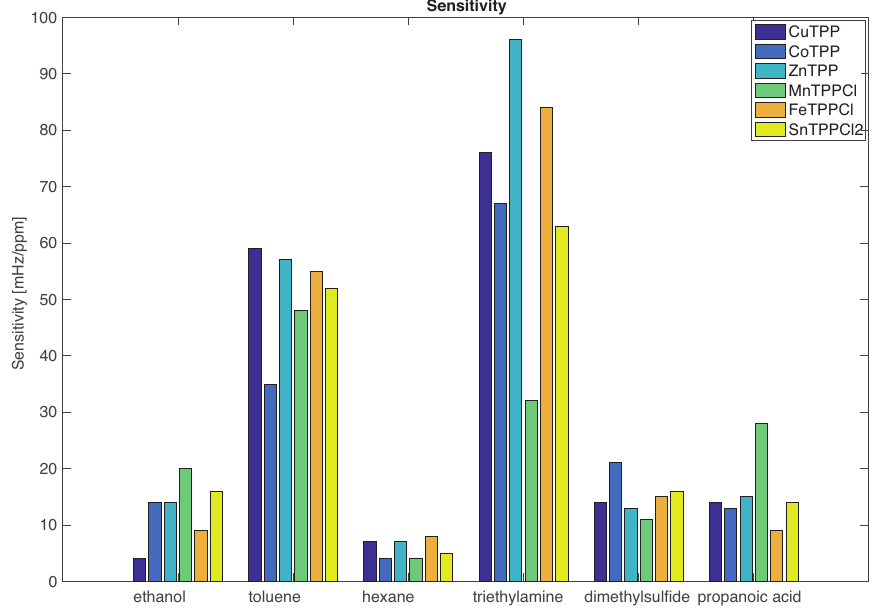
Figure 3. Sensors sensitivity respect to each